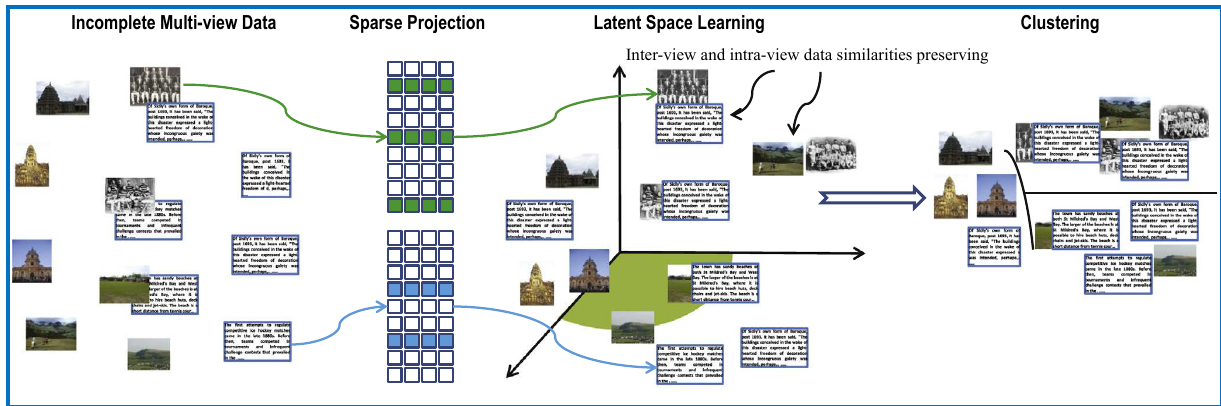
Fig. 10 The overview of the proposed model with two views, i.e., text and image [124] . For the incomplete multi-view dataset, it uses a projection matrix in order to project the original features (text and image) to a latent space, which explicitly captures the clustering structure. Moreover, group sparsity is imposed on projection matrices for feature selection. Moreover, inter-view and intra-view data similarities are preserved in order to enhance the model. Finally, the features on this latent space are applied to the clustering